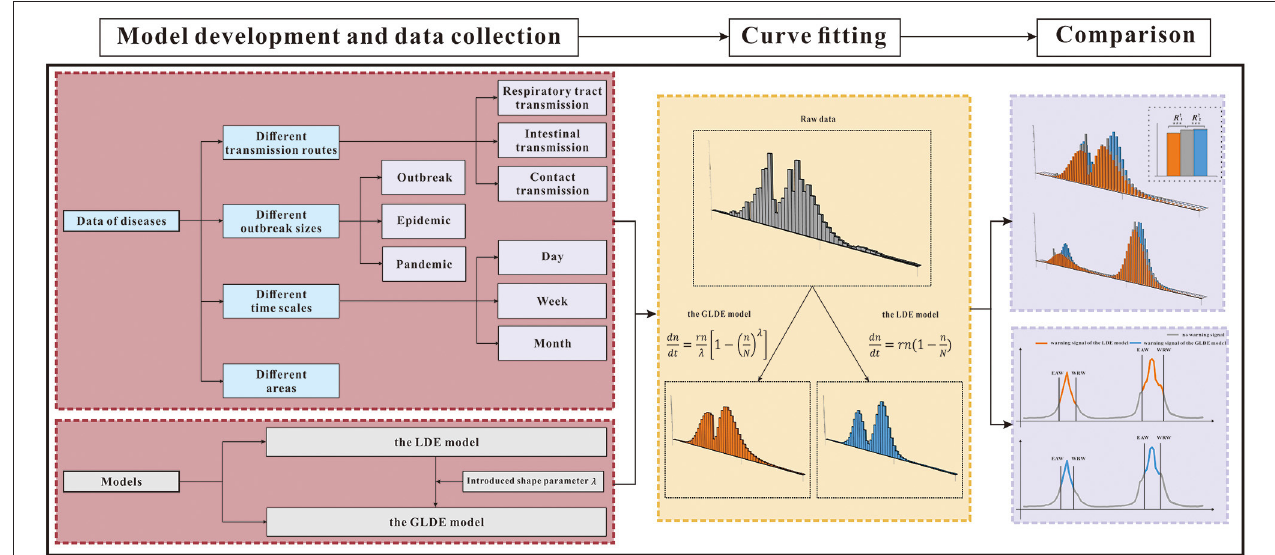
FIGURE 1 | Research framework. GLDE, Generalized logistic differential equation; LDE, logistic differential equation; ** p < 0.01; *** p < 0.001; EAW, epidemic accelerate week; WRW, warning remove week.